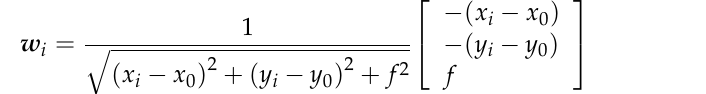
x-axis, ω y is the angular velocity around the y-axis, ω z is the angular velocity around the z-axis, ( x 0 , y 0 ) is the centroid coordinate of star i at the initial moment t 0 , and ( x 1 , y 1 ) is the centroid coordinate at the next moment t 0 + ∆ t